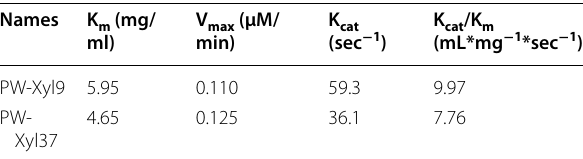
Table 2 Enzyme activity parameters of